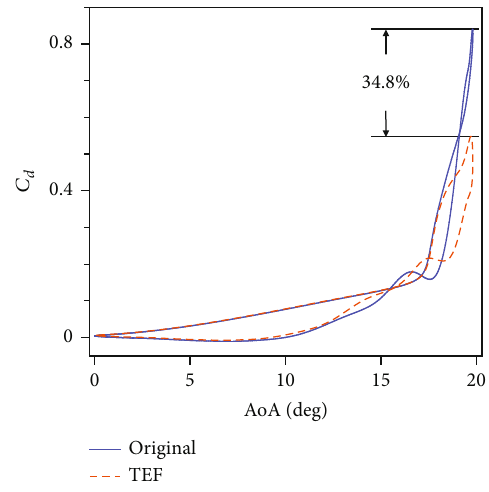
Figure 10: Comparison of drag coe ffi cients between the original and TEF airfoils.